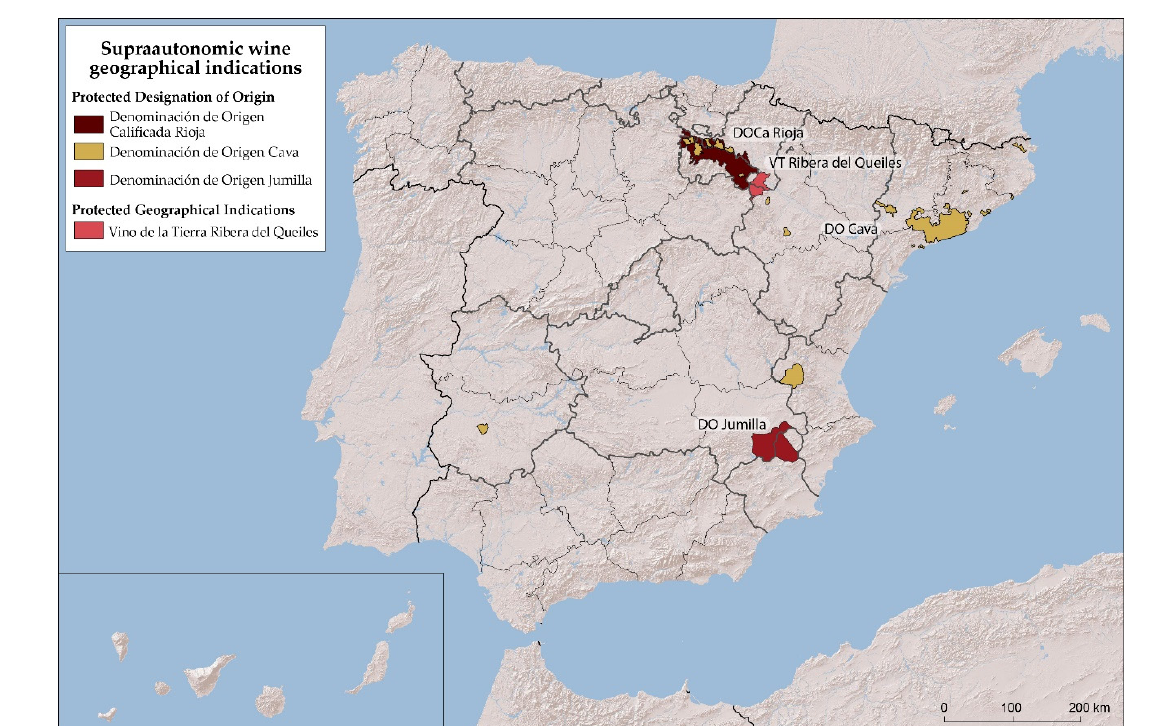
Figure 6. Supraautonomic wine geographical indications. Source: European Commission. eAmbrosia. The EU geographical indications register. Retrieved from: https://ec.europa.eu/geographical- indications-register/ (accessed on 20 January 2022) and Spanish Ministry of Agriculture, Fisheries and Food. Own